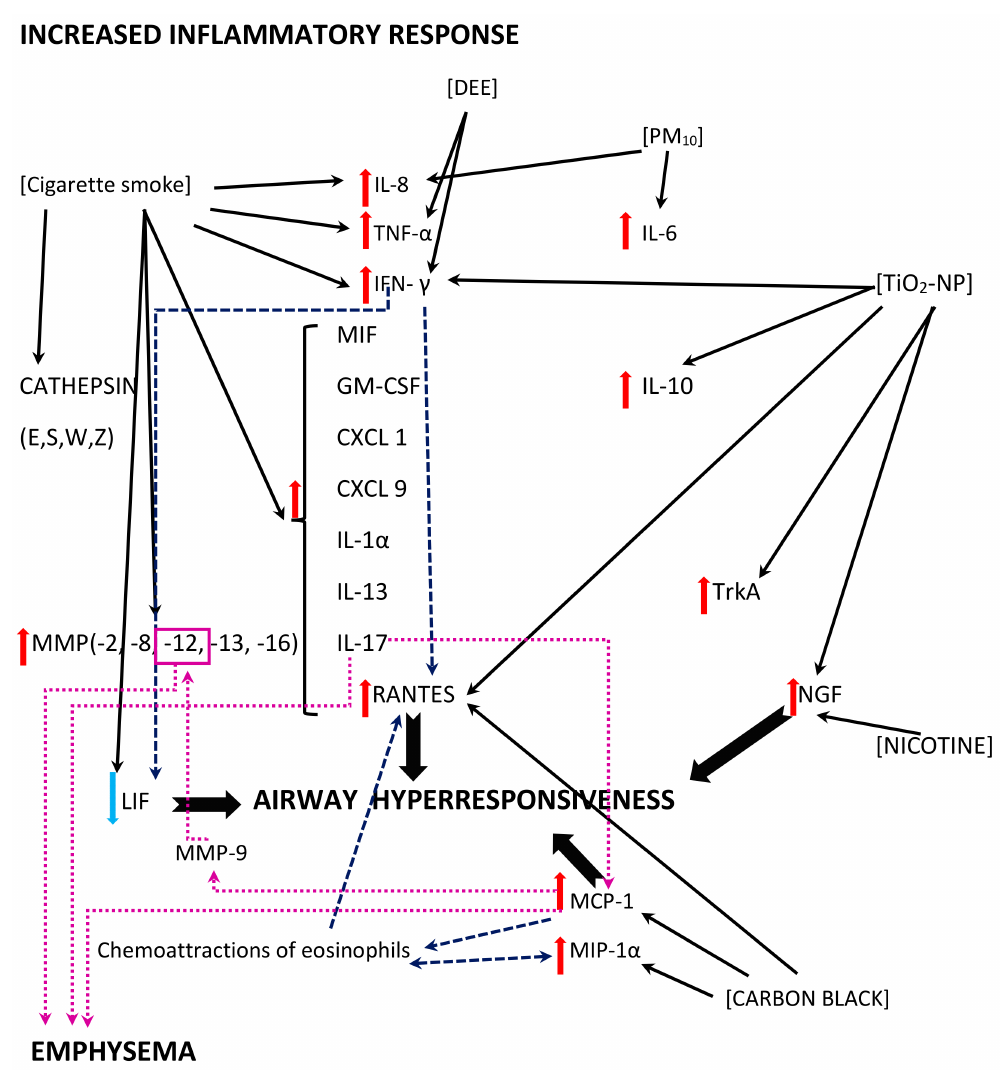
Figure 6. A diagram of the exuberant inflammatory response and its effects; multidirectional interac- tions between the air pollutants (shown in square brackets) and inflammatory mediators, including cytokines and chemokines are shown. The black solid line arrows reflect direct effects of the air pollutants revealed in the studies; the dashed navy blue line arrows reflect additional effects of the inflammatory mediators or immune cells contributing to the effects; the dotted magenta line arrows reflect the mechanisms related to the pathomechanism of